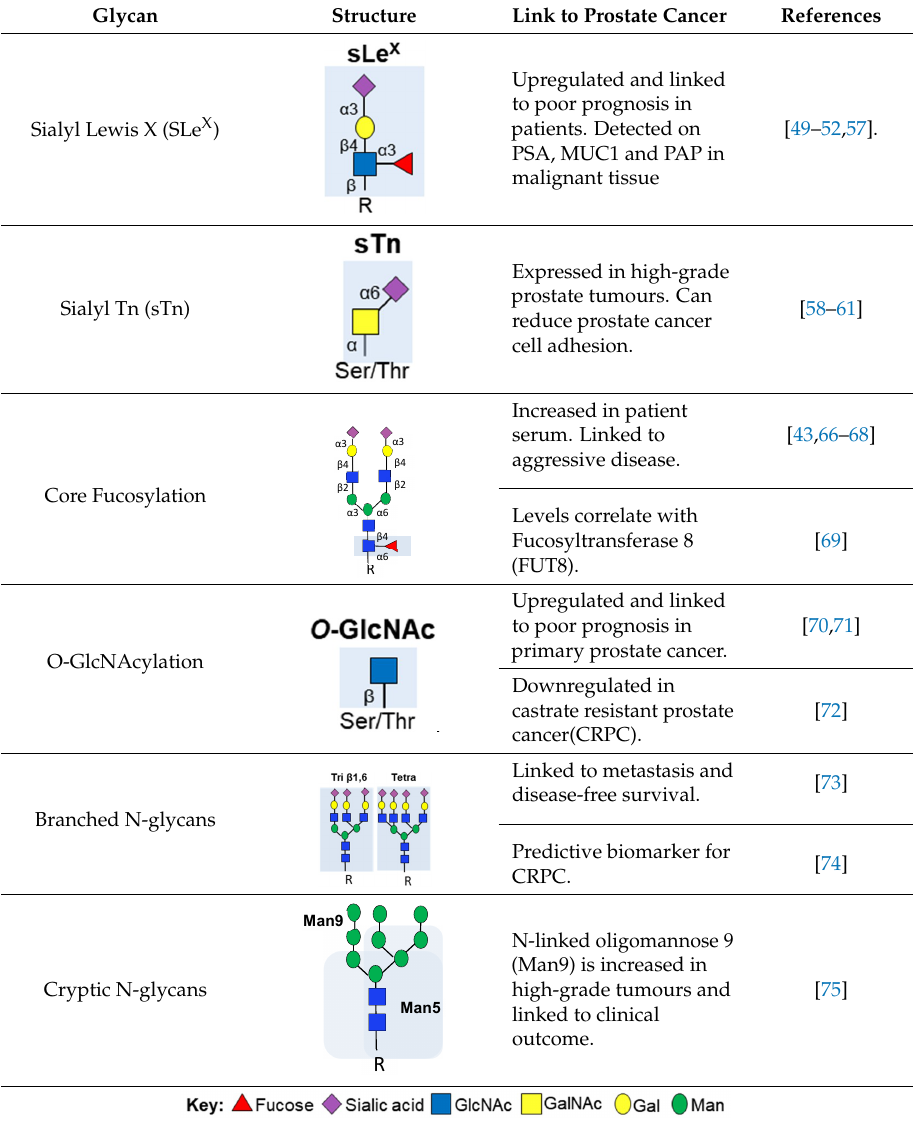
Cryptic N-glycans N-linked oligomannose 9 (Man9) is increased in